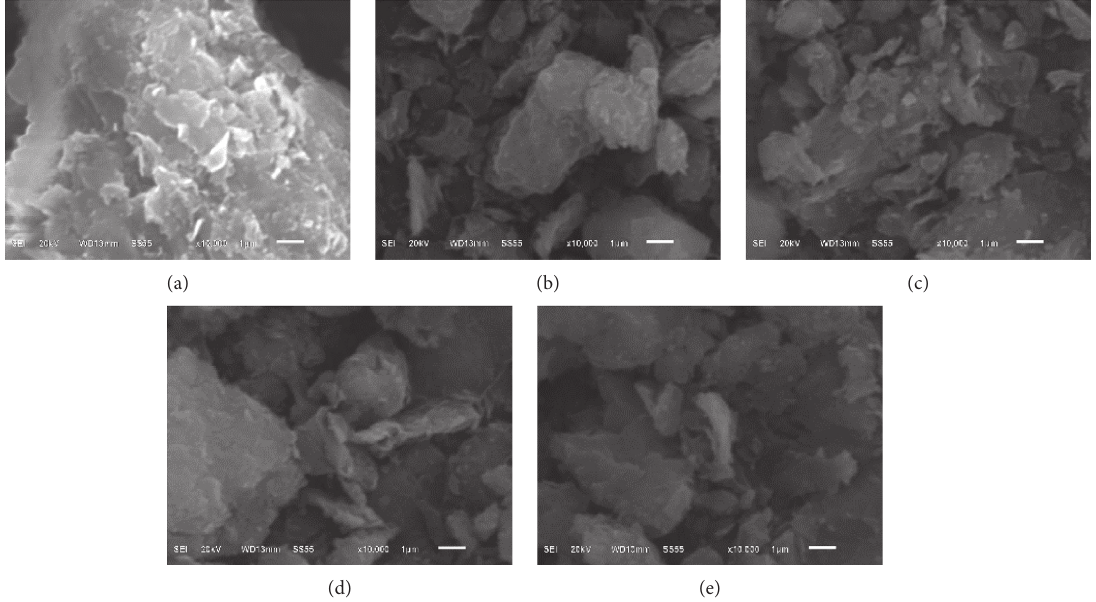
Figure 5: Scanning electron microscope (SEM) images of bentonite treated with a variety of alkaline solution concentrations: (a) distilled water, (b) 0.3M NaOH, (c) 1.0M NaOH, (d) 0.3 M KOH, and (e) 1.0 M